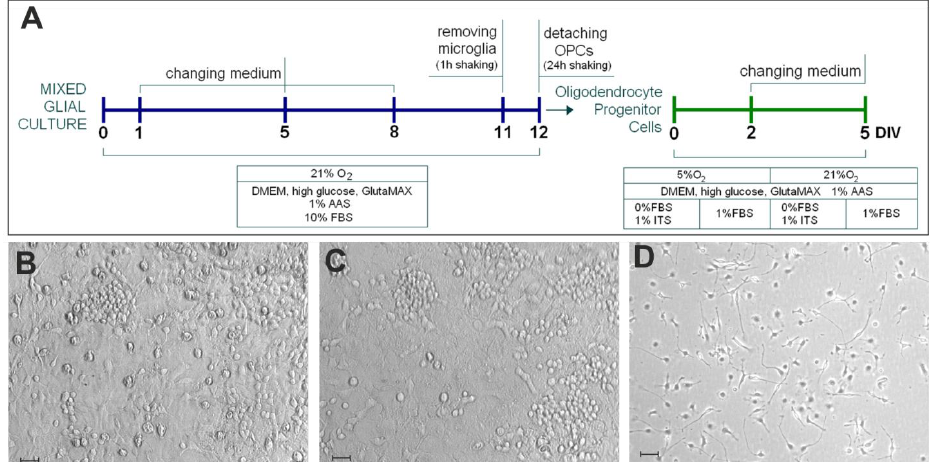
Figure 1. Establishing the monocultures of oligodendroglial progenitors in vitro. ( A ) A scheme of oligodendrocyte progenitor cells (OPC) isolation from the primary mixed glial culture (blue timeline) and their subsequent differentiation in four variants of cell culture conditions (green timeline); ( B ) live image of a mixed primary glial cell culture obtained from the brains of neonatal rats; ( C ) the cell culture after shaking off the microglial fraction; ( D ) OPC monoculture 24 h after cell seeding. The scale bar corresponds to 50 µm.